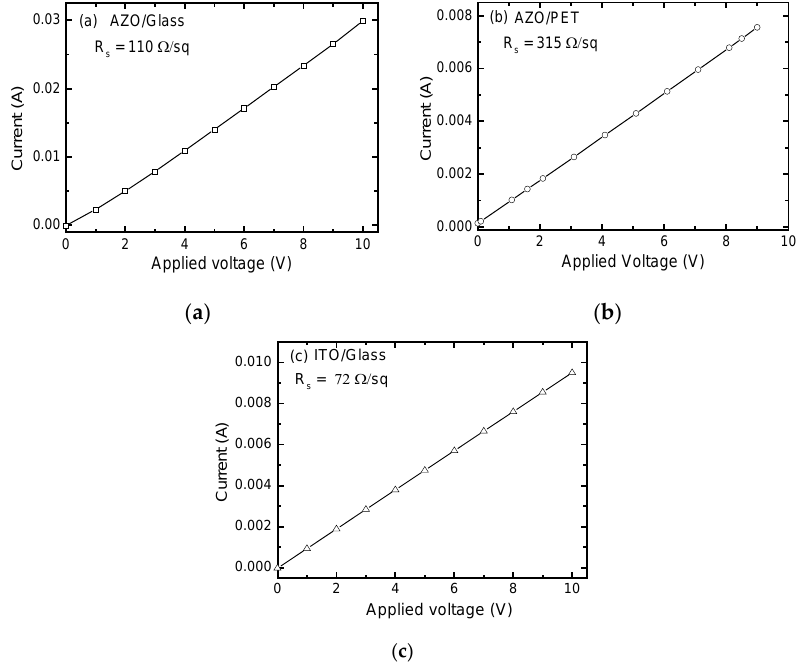
Figure 3. Current–voltage characteristics of AZO thin films deposited on ( a ) glass and ( b ) PET, as well a comparison with ( c ) commercial ITO/glass, are shown for reference.